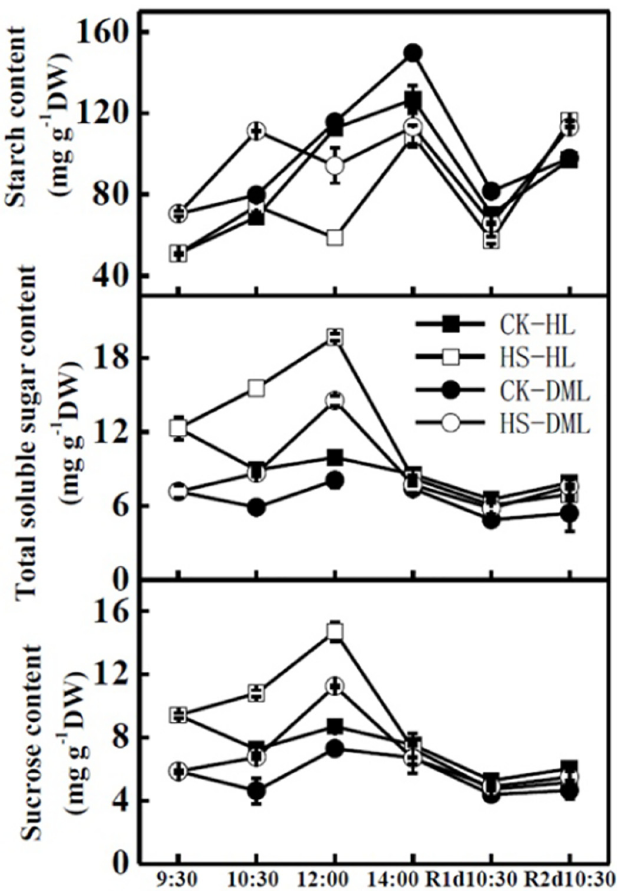
Fig 4. Effects of heat shock and recovery on the starch content, total soluble sugar content, and sucrose content in leaves of healthy and downy mildew-infected cucumber. The data represent the mean ± SE (n =